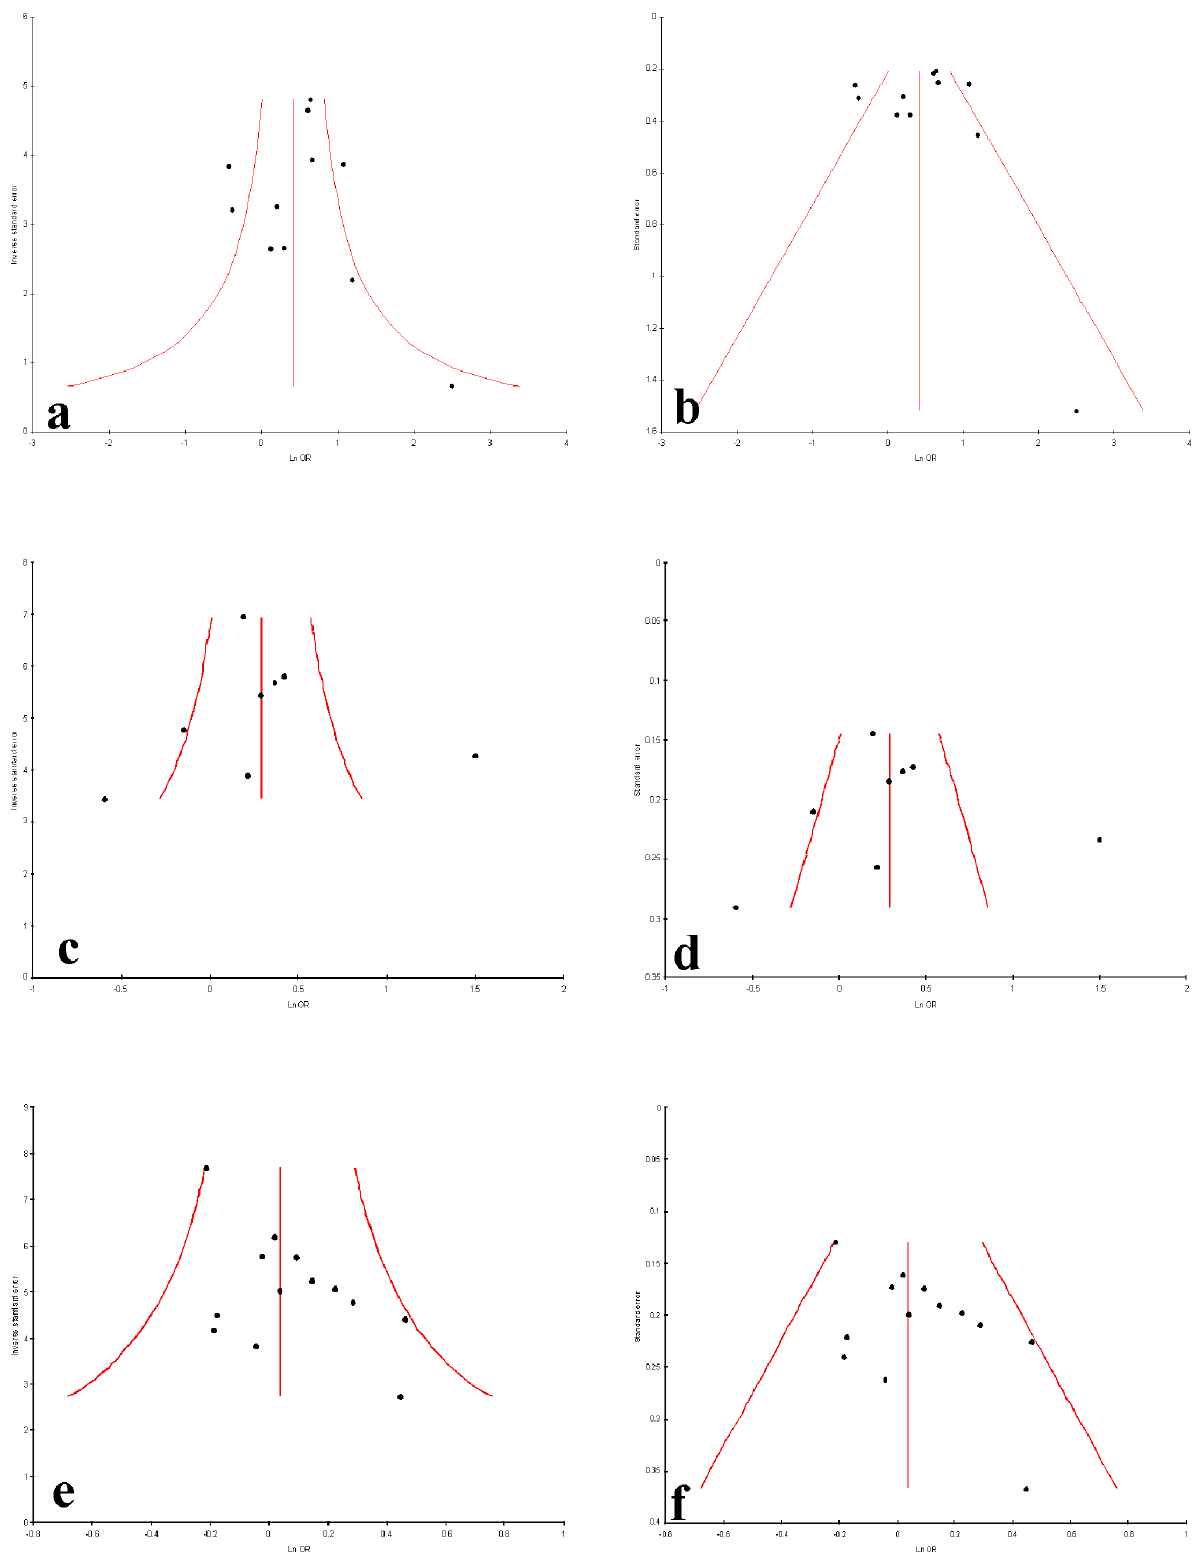
Figure 9. Funnel plots a 2 f. a. Precision by log odds ratio for additive model; b. standard error by log odds ratio for additive model for Asian studies; c. precision by log odds ratio for additive model; d. standard error by log odds ratio for additive model for American studies; e. precision by log odds ratio for additive model; f. standard error by log odds ratio for additive model for European studies.